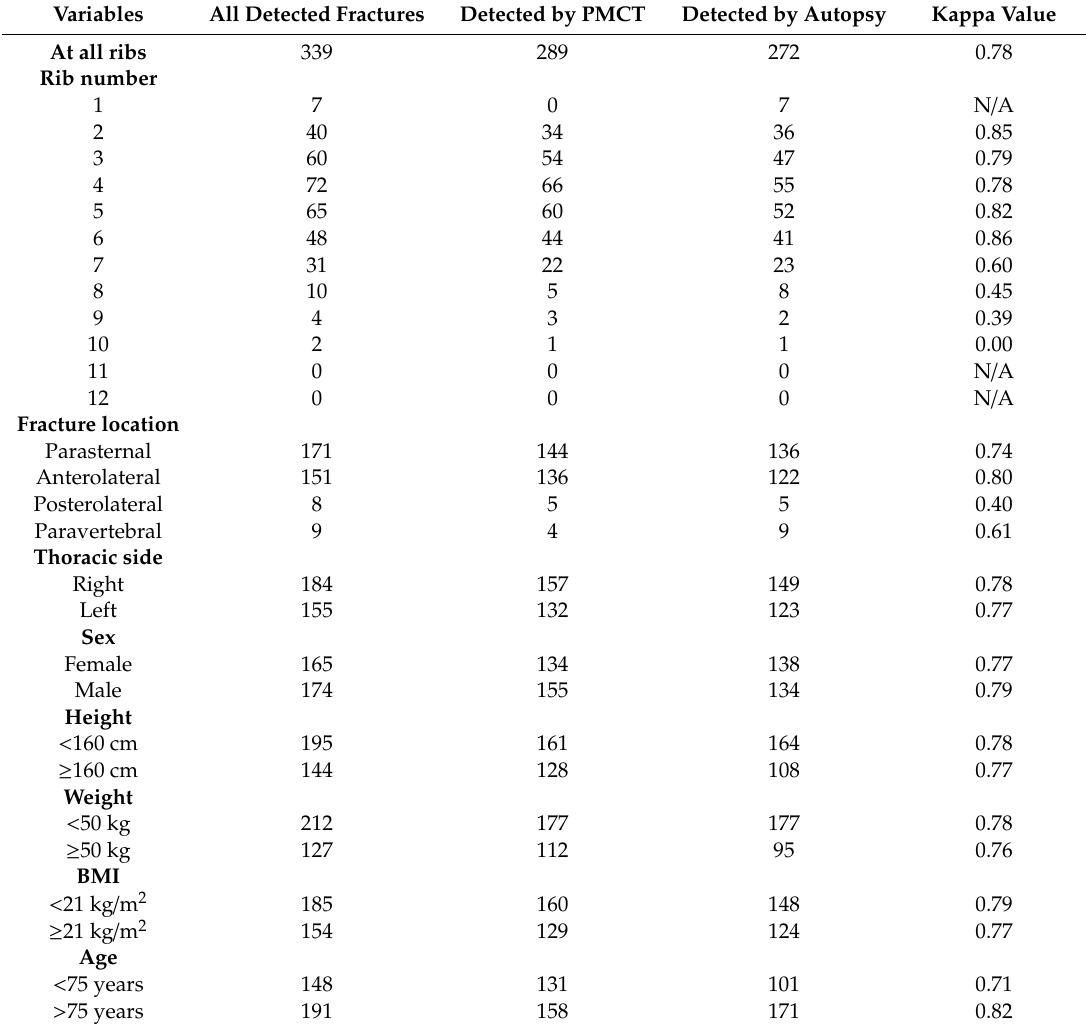
Table 2. Characteristics of rib